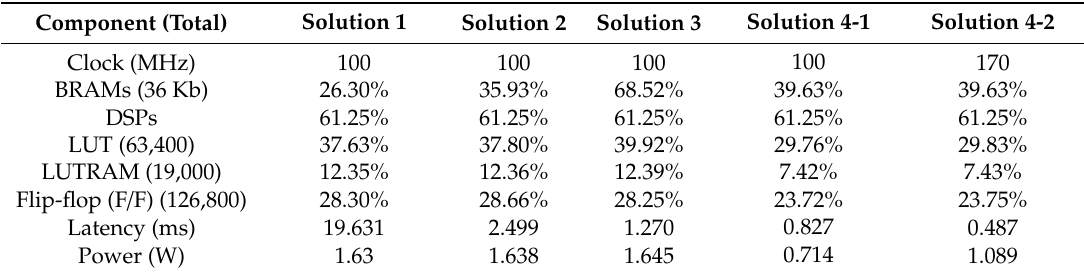
Table 3. Resource consumption and performance of di ff erent solutions on FPGA.